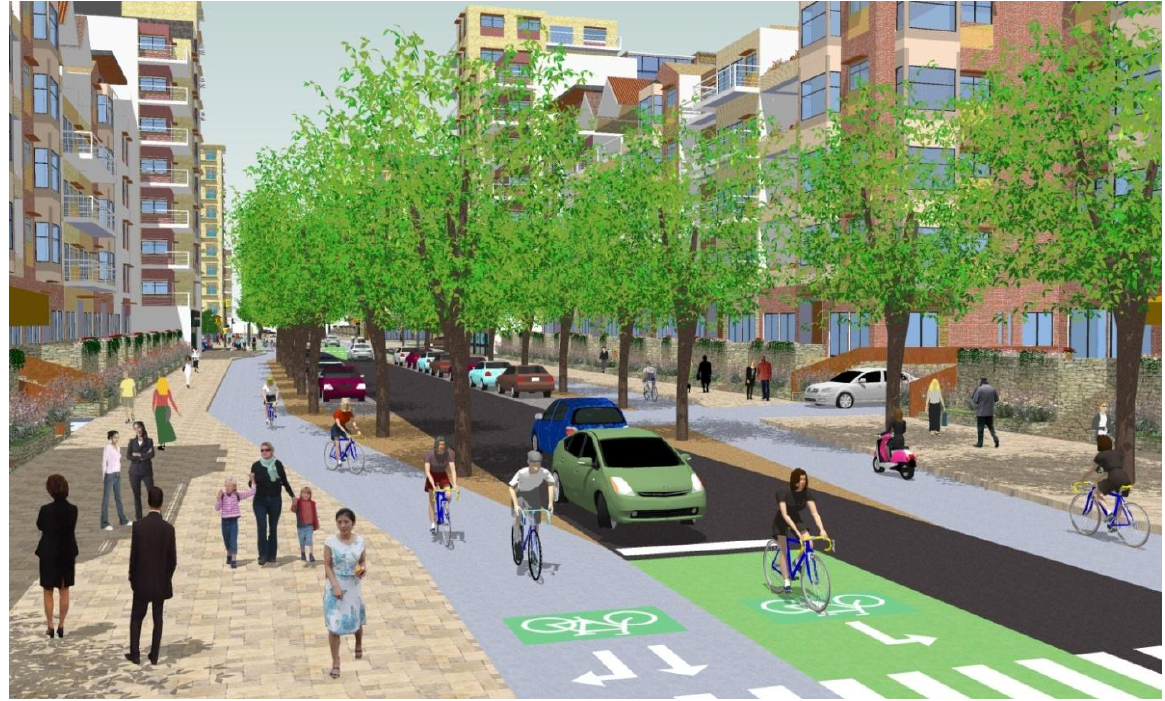
Figure 4. Example of street and building